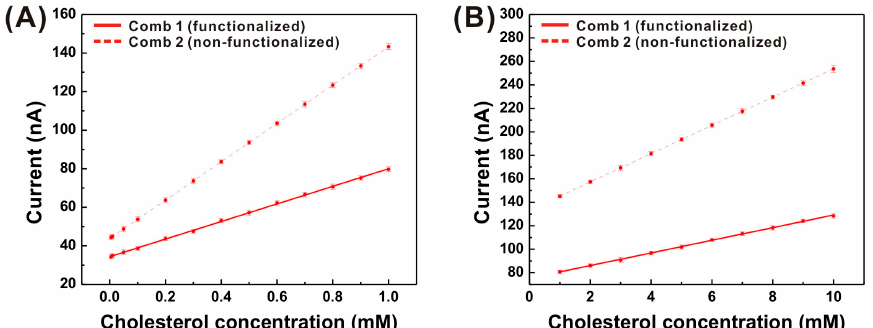
Figure 6. Chronoamperometric current responses of comb 1 and comb 2 of AuNP/carbon IDEs corresponding to various cholesterol concentrations: ( A ) 0.005–1 mM cholesterol, ( B ) 1–10 mM Table 1. Comparison of sensing performance between bare carbon and AuNP/carbon IDE-based cholesterol biosensors.